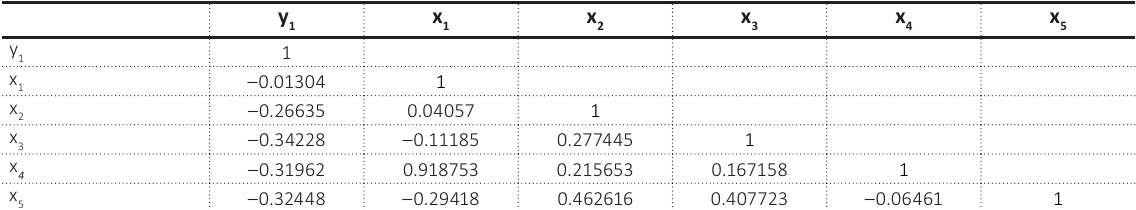
Table 6. Matrix of pair correlation indices of the Gini coefficient (у1) and social spending items